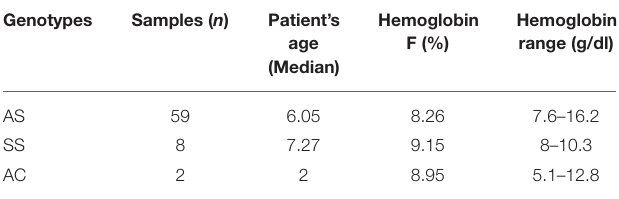
TABLE 2 | Genotype and hemoglobin F %. Genotypes